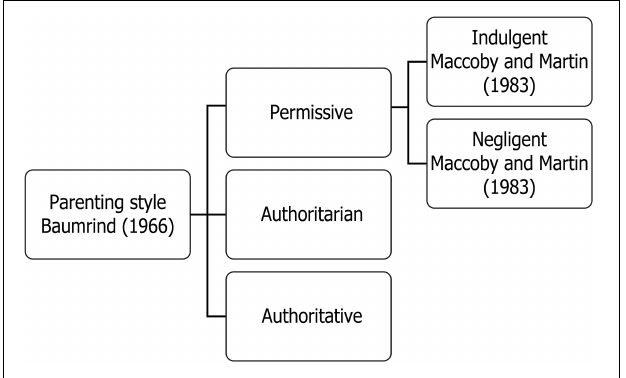
FIGURE 1 | Parenting style as presented by Baumrind (1966) and modified by Maccoby and Martin